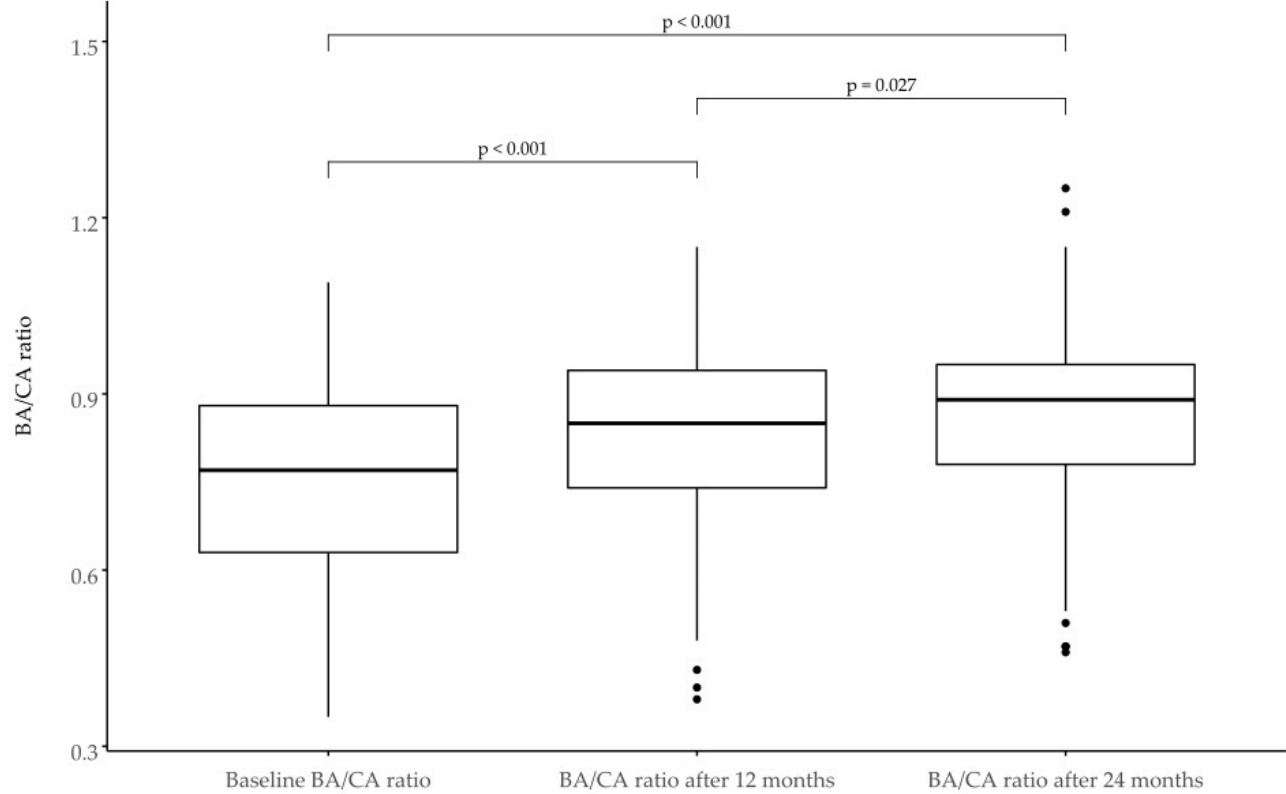
Figure 6. Bone age/calendar age ratio (BA/CA) in SGA children at the baseline and after 12 and 24 months of treatment.